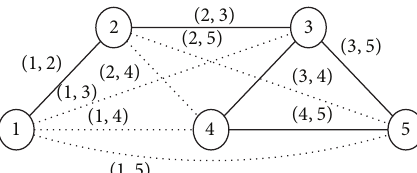
Figure 3: Graph of Example 3. 𝐺 has 𝑛 = 5 nodes and 𝑚 = 5 edges (solid lines); all other possible edges including labels in 𝐸(𝑉) are shown as dotted